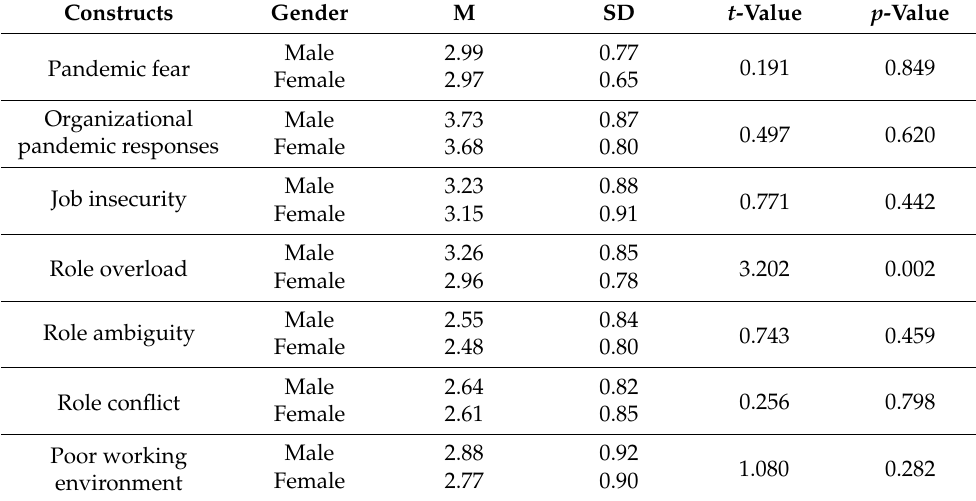
Table 6. Independent sample t -test of the gender differences for perceived